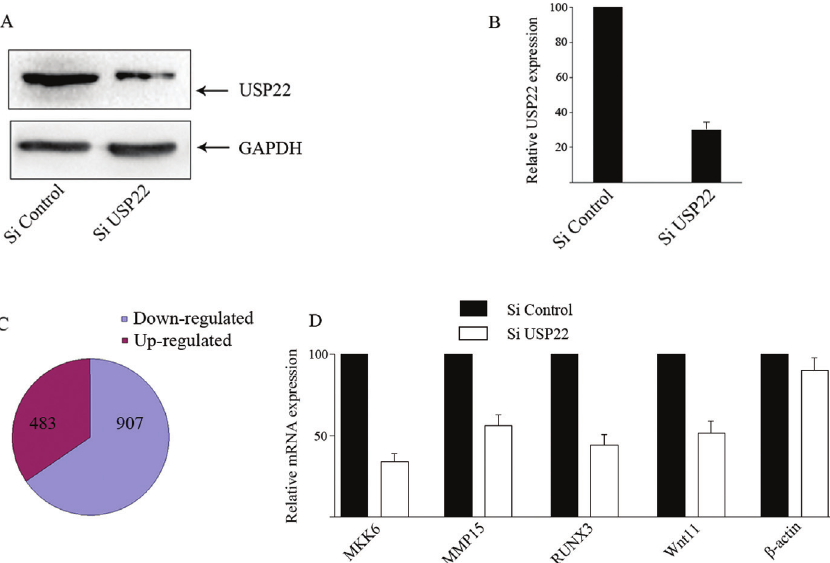
Figure 4 - Knockdown of UPS22 by siRNA modulates gene expression in HeLa cells. (A and B) Western blot analysis of USP22 silencing in HeLa cells. (C)Piechartsshowtheratioofup-regulatedordown-regulatedgenesbyUPS22silencinginHeLacells.(D)QuantitativeRT-PCRanalysisoftherelative levels of mRNA transcripts of some genes targeted by UPS22. Data are expressed as the mean (cid:7) SD of each group of genes and the levels of mRNA tran- scripts in the control siRNA-transfected cells were designated as 100. Data are representative of three independent